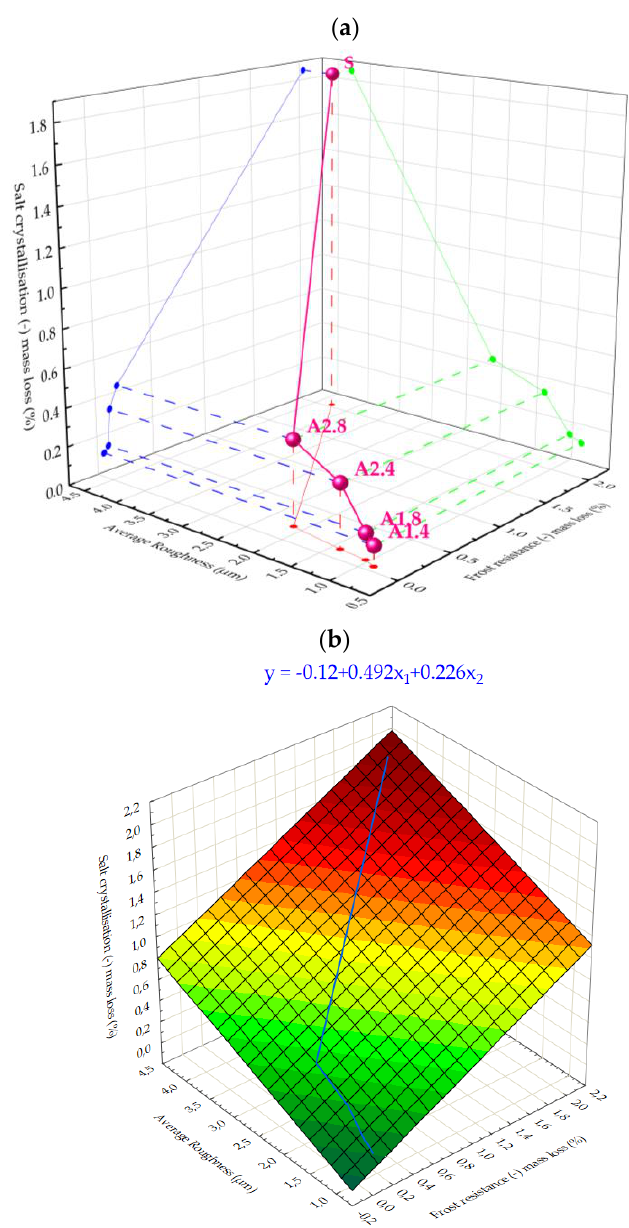
Figure 7. Correlation between micro-roughness, frost resistance and resistance to water-soluble salts: ( a ) 3D Scatter, ( b ) 3D Surface Plot.